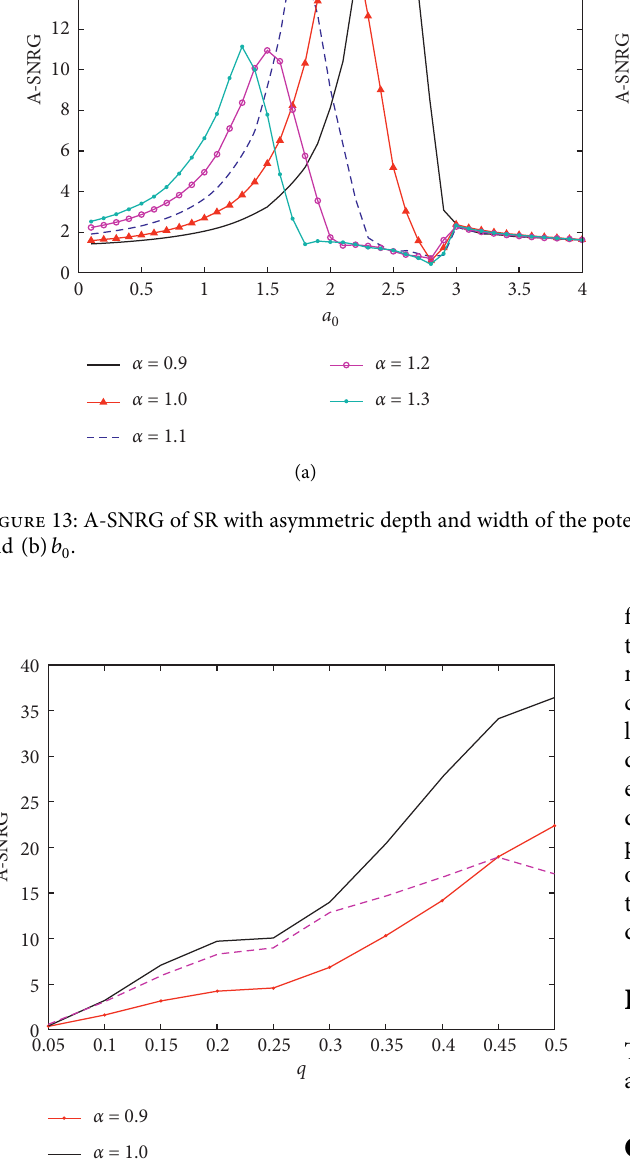
Figure 14: A-SNRG of SR with asymmetric depth and width of potential well as a function of potential function parameter q